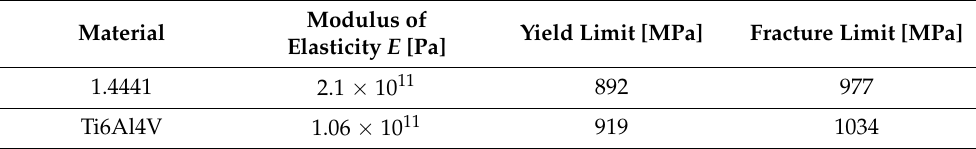
Table 1. Basic material information on the applied